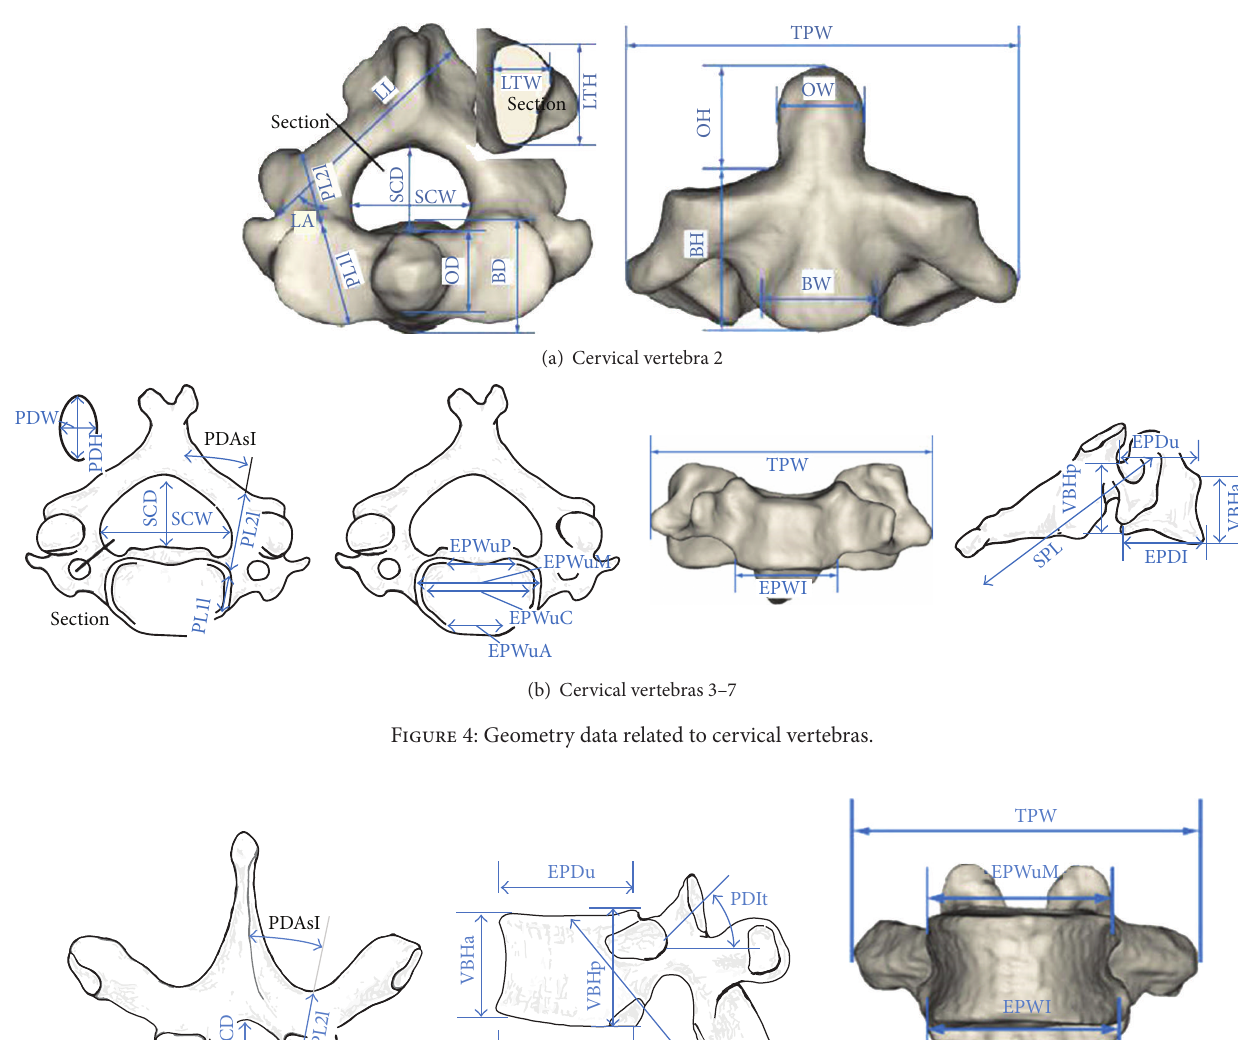
Figure 5: Geometry data related to thoracic vertebras.